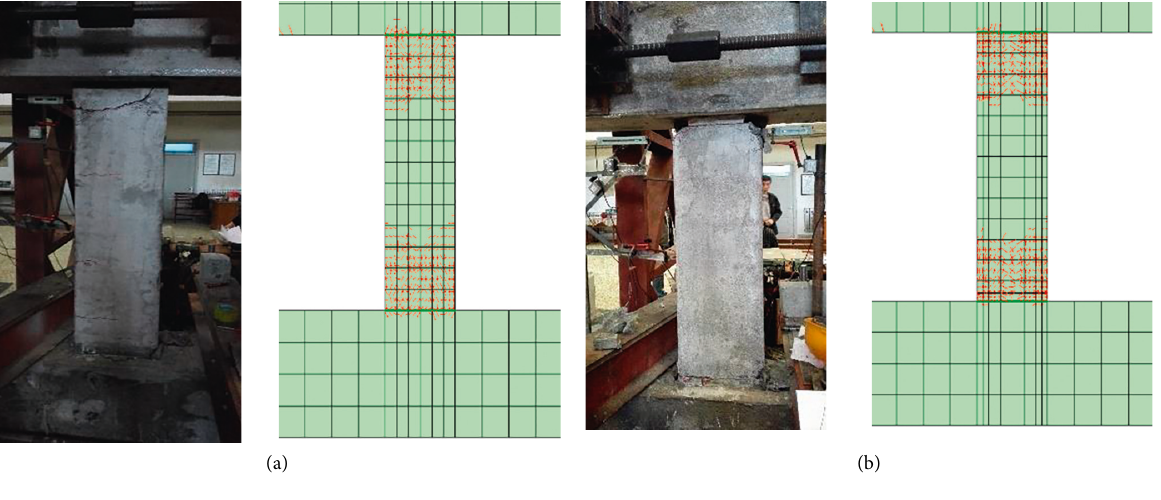
Figure 13: Cracking of the specimen. (a) XJ1. (b) ZP1.